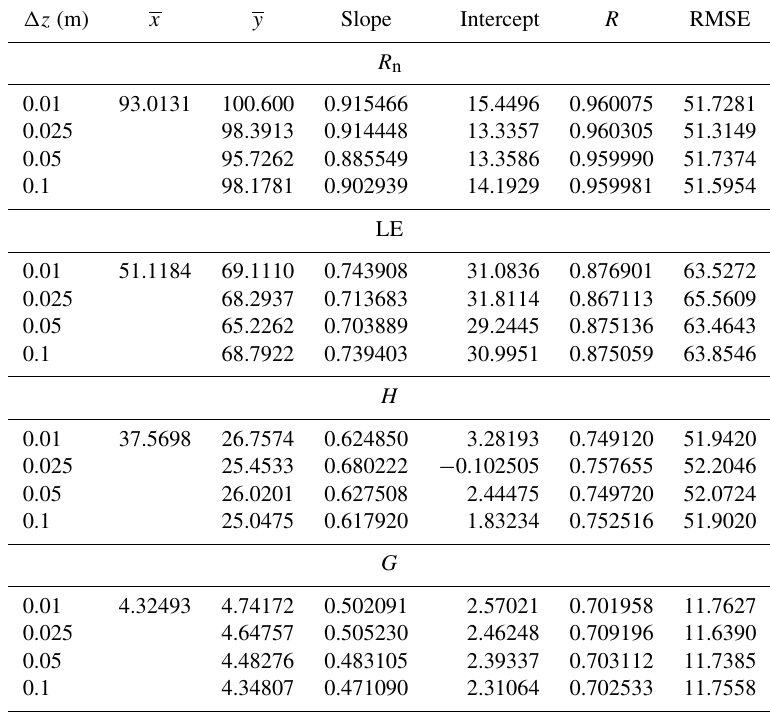
Table 2. Results of the linear regressions between the energy balance observations ( x axis) and the simulations ( y axis) for the simulations with a numerical solution of the heat conduction equation. Units are Wm − 2